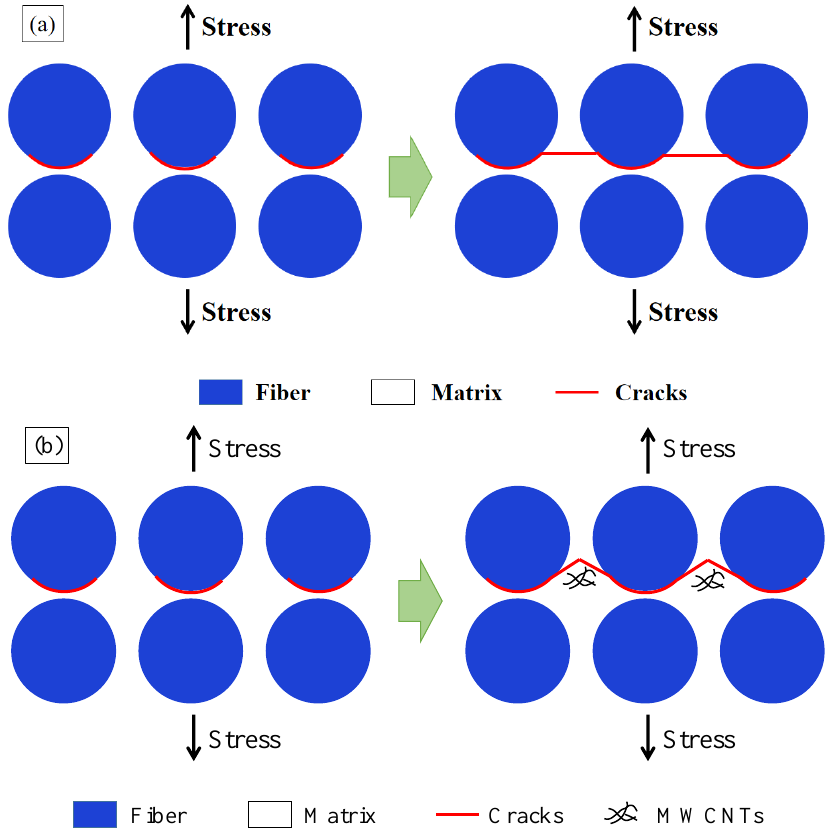
Figure 15. Schematic of fracture mechanism: ( a ) original specimens; ( b ) MWCNTs toughening specimens.